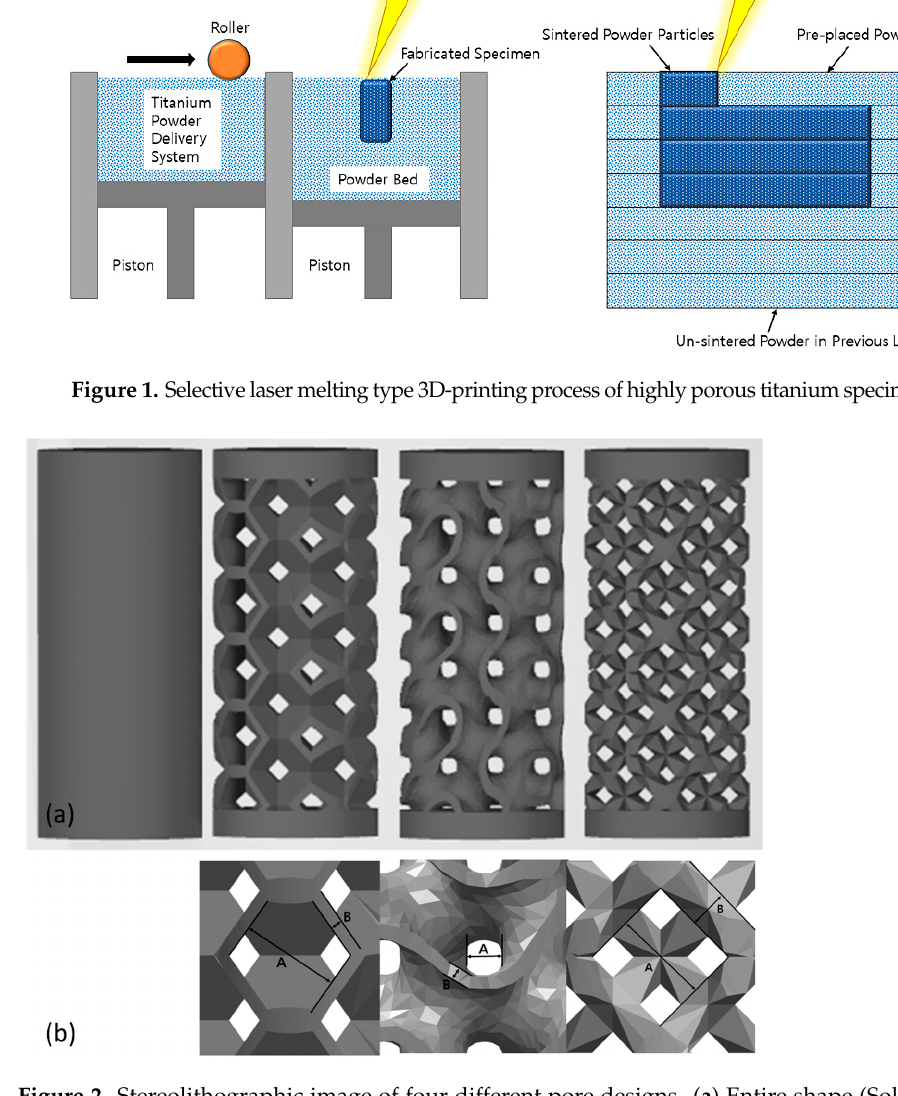
Figure 2. Stereolithographic image of four different pore designs. ( a ) Entire shape (Solid (sham), Octadens, Gyroid, and Dode). ( b ) Image of the unit cell (Octadens, Gyroid, and Dode) (A: pore size, B: strut thickness).